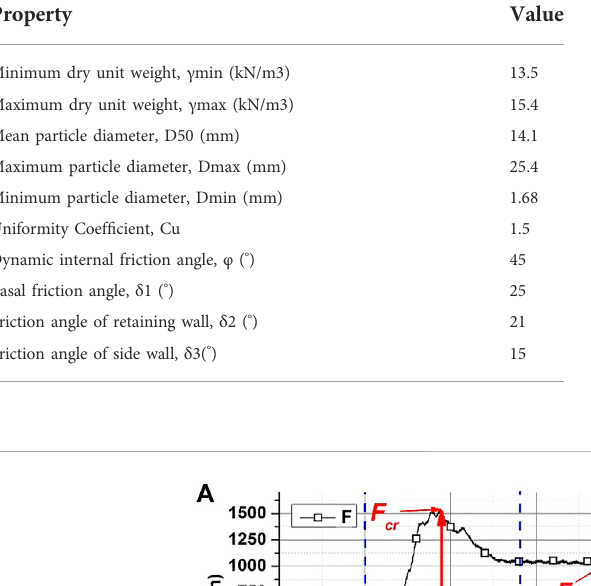
TABLE 1 Physical properties of